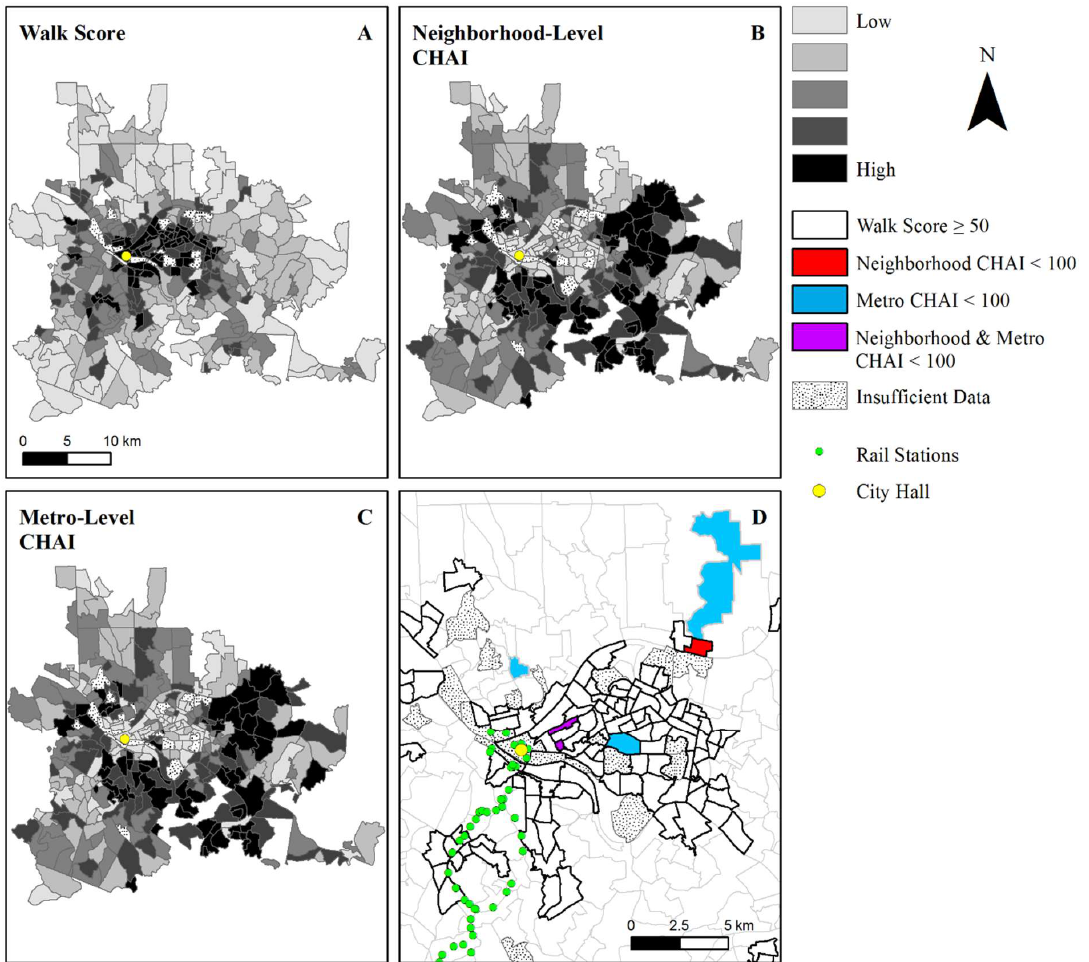
Figure 2. The spatial relationship between ( A ) walkability and housing affordability calculated at the ( B ) 381 neighborhood and ( C ) metropolitan scale for census tracts within the urbanized area of Pittsburgh, PA. Of 382 particular interest is where ( D ) relatively high walkability and low housing affordability overlap. The 383 comprehensive housing affordability index (CHAI) was calculated by summing the standardized housing 384 affordability for home owners and renters, and weighing each based on their proportion within each census 385 tract. 386